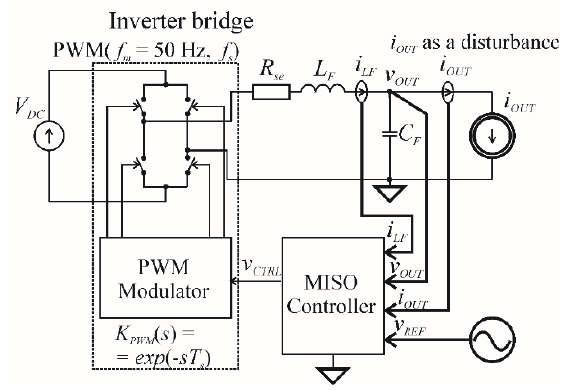
Figure 1. MISO control of a VSI. Load current i OUT is treated as an independent disturbance. The influence of the equivalent serial resistance R se must now be determined, which varies with the use of different switching technologies, on the design of the control loop. The system is passive whenever the energy supplied to the system exceeds the stored energy. Within an inverter, energy is stored in two non-dissipative components—the filter coil and the filter capacitor. The energy stored within a system is described by the Hamiltonian function H ( x ) (also known as the Lyapunov function [17]). The Hamiltonian function of the error vector e is Equation (1). 2 2